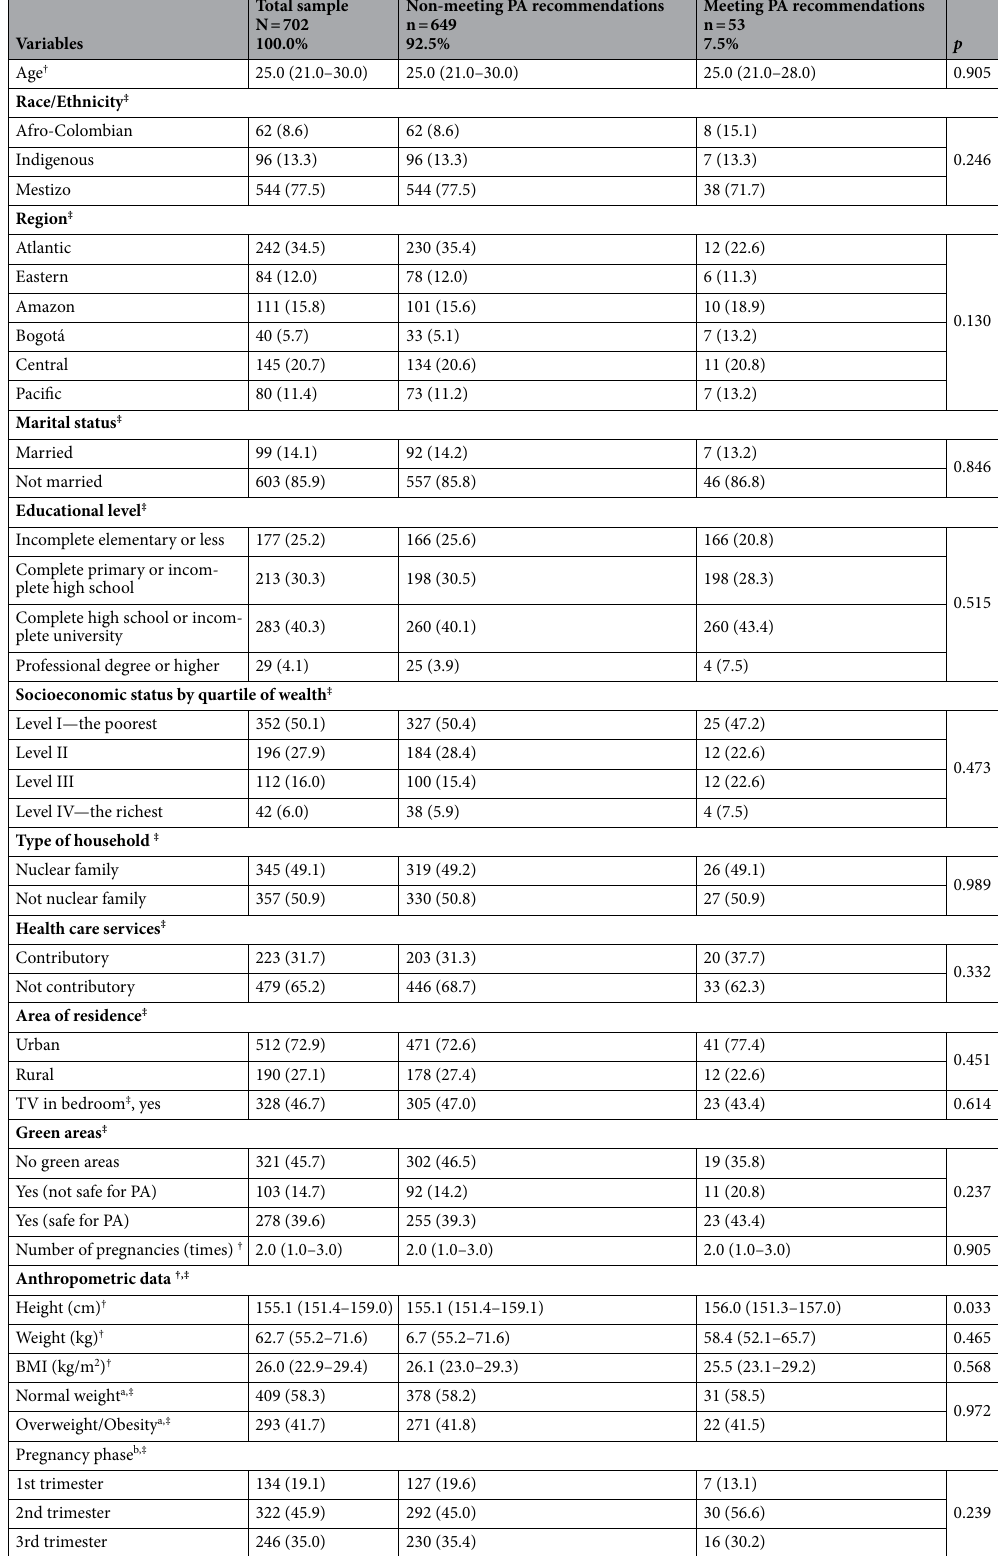
Table 1. Socioecological correlates of the Colombian pregnant women and according to meeting the physical activity recommendations. BMI: Body mass index; PA: Physical activity. † Data expressed as median (interquartile range). ‡ Data expressed as number (percentage). a Prevalence of excess of weight according to the cut-off points proposed by Atalah et al. 27 for Colombian pregnant women. b According to the week of the last menstruation period. c It includes the sum of weekly minutes of moderate physical activity, vigorous physical activity and active